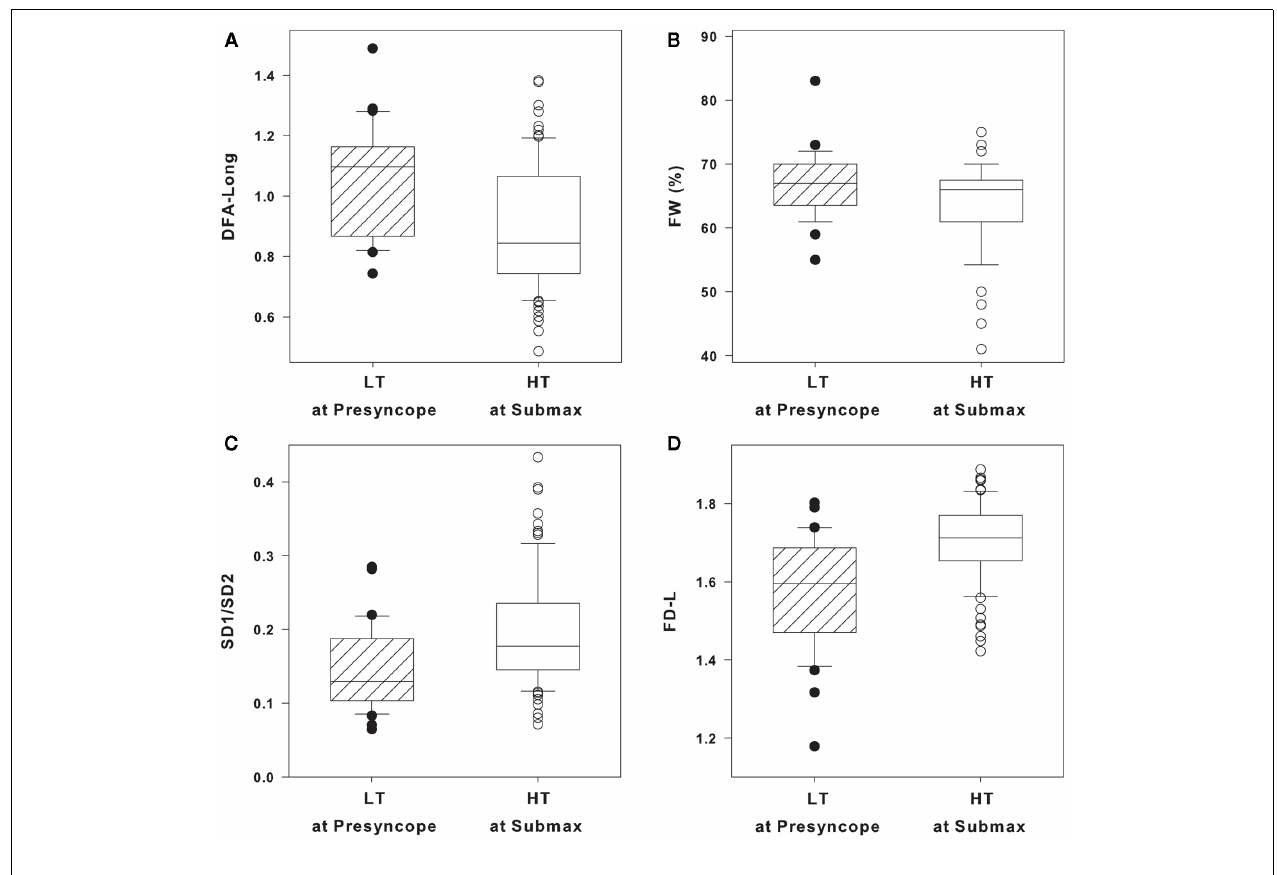
n = 33) and high tolerant (HT) at submax (open circles, n = 87) level of lower body negative pressure (LBNP). Data are shown as box (25th/75th percentiles) and whisker (90th/10th percentiles) plots with median value (black